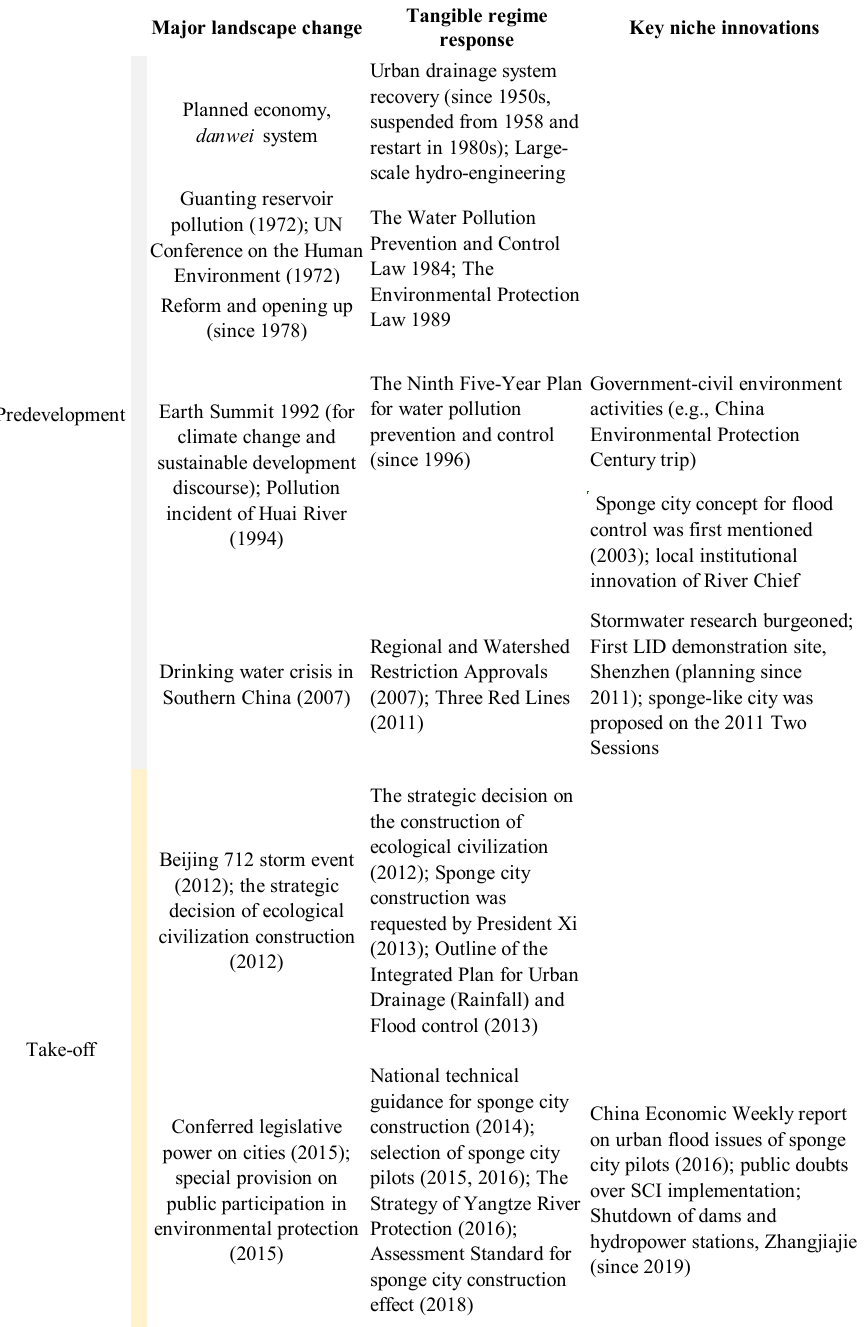
Figure 2. The transition trajectory of the Chinese stormwater management. Based upon the historical timeline, the transition phases and pathways of the two countries are analyzed. The multi-phase model is often used to identify different transition stages. Four phases were identified: predevelopment, where the regime is relatively stable while some niches may emerge under landscape pressure; take-off phase, where change starts to build up and the regime begins to shift; acceleration phase, in which structural changes occur in a visible way; and stabilization, when the new system reaches equilibrium again [29]. These stages have general descriptions in some of literature [13,29–31], making comparisons requires indicators developed specifically for SSWM transition to make the evaluation criteria consistent (Table 1). The indicators for entering stabilization are